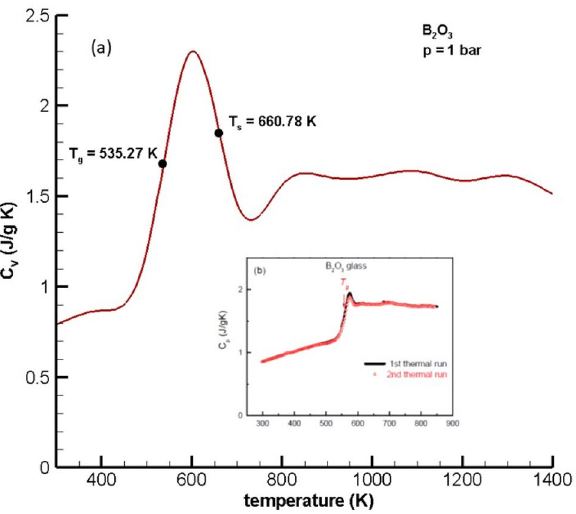
Figure 1. Heat capacity, C V , vs. temperature for boron trioxide at 1 bar ( a ) Predicted by Monte Carlo simulation. ( b ) Inset: Experimental C p Data Taken from D’Angelo and Carini 44